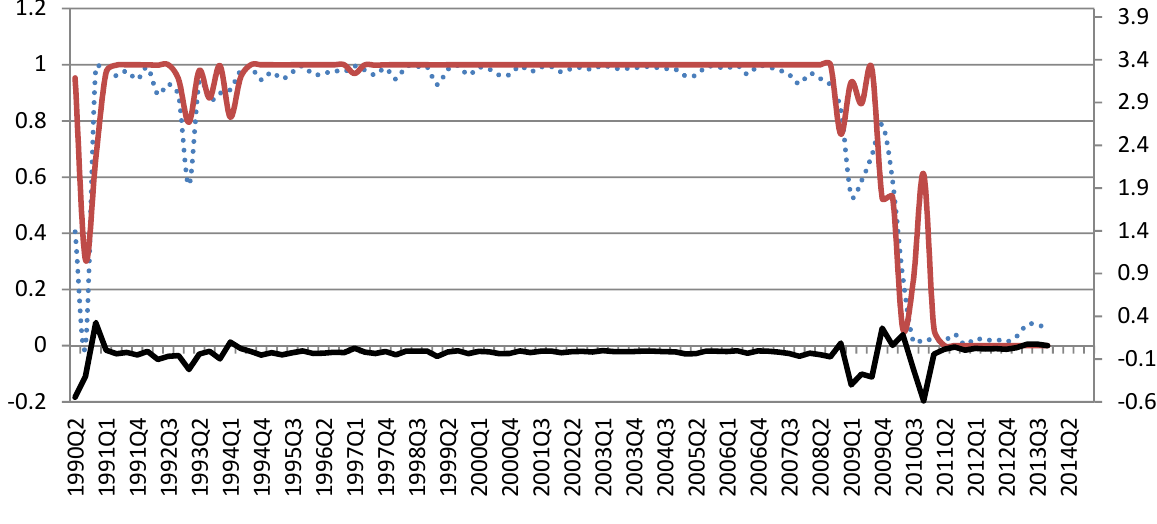
Figure 3. Filtered probability of GDP being in boom state (d t = 1) along with its estimate. The sample period runs from 1990q1 to 2013q4.